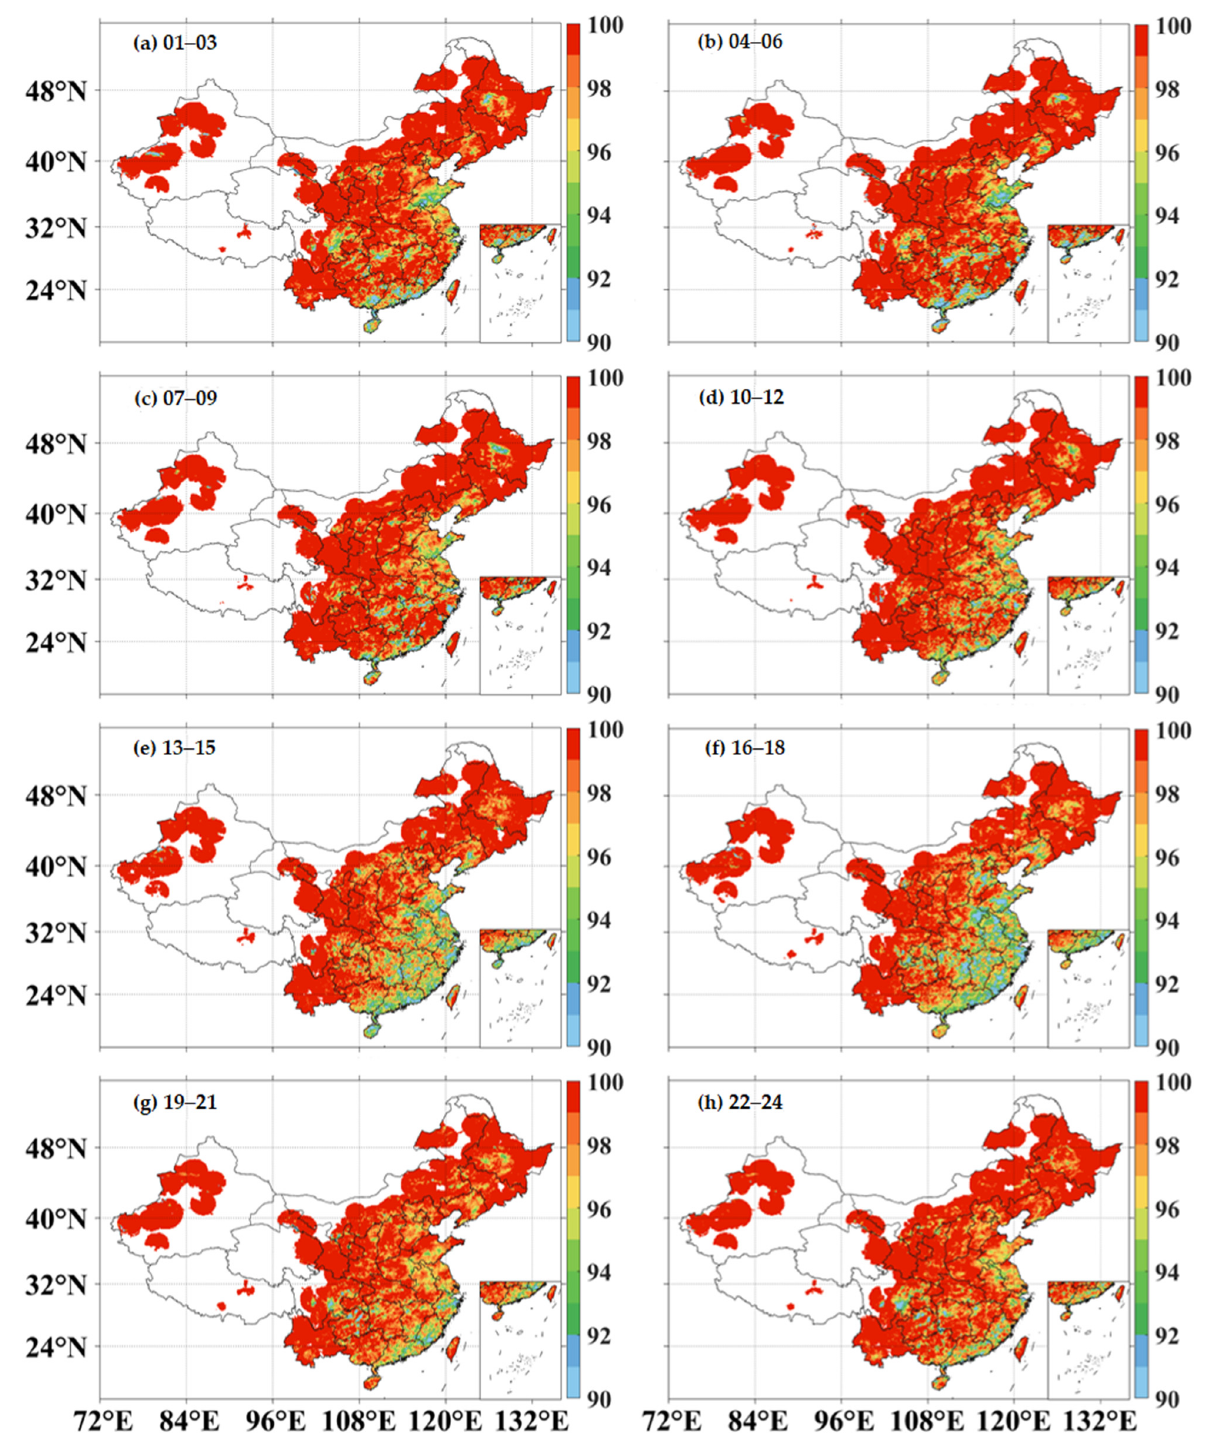
Figure 13. Diurnal variation of frequency (%) distribution of stratiform precipitation for period 01–03, 04–06, 07–09, 10–12, 13–15, 16–18, 19–21, and 22–24 LST in August from 2018 to 2021. From June to August, the frequency of snowfall every 3 h shows a spatial distri- bution that is completely different from those of convective and stratiform precipitation (Figures 14–16). The snowfall is primarily located in the high mountain and plateaus at night. The high frequency of snowfall is pronounced in the Qinghai-Tibet Plateau and the Tianshan Mountains during 19–12 LST (Figure 14a–d,g,h) and around the Qilian